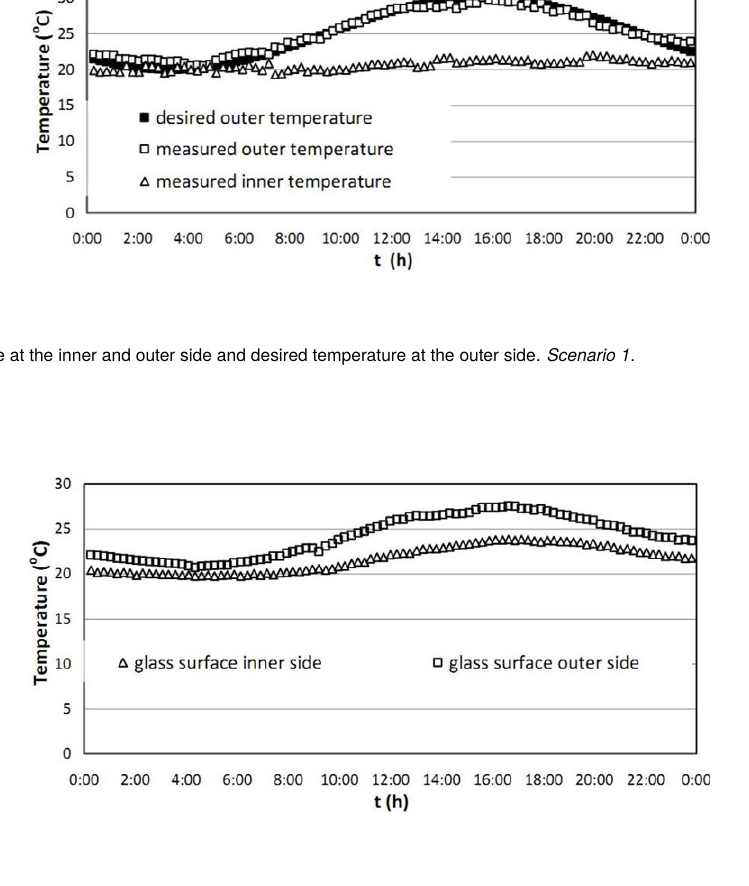
Figure 9. Measured temperature at the external triple glazing surfaces at inner and outer side. Scenario 1 .